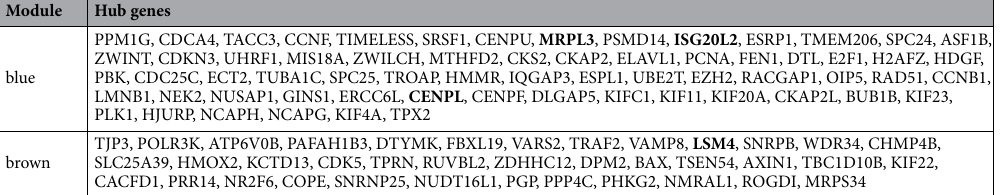
Table 3. Hub genes identified in the blue and brown modules associated with breast tumor via WGCNA analysis. Four selected genes are annotated in bold.